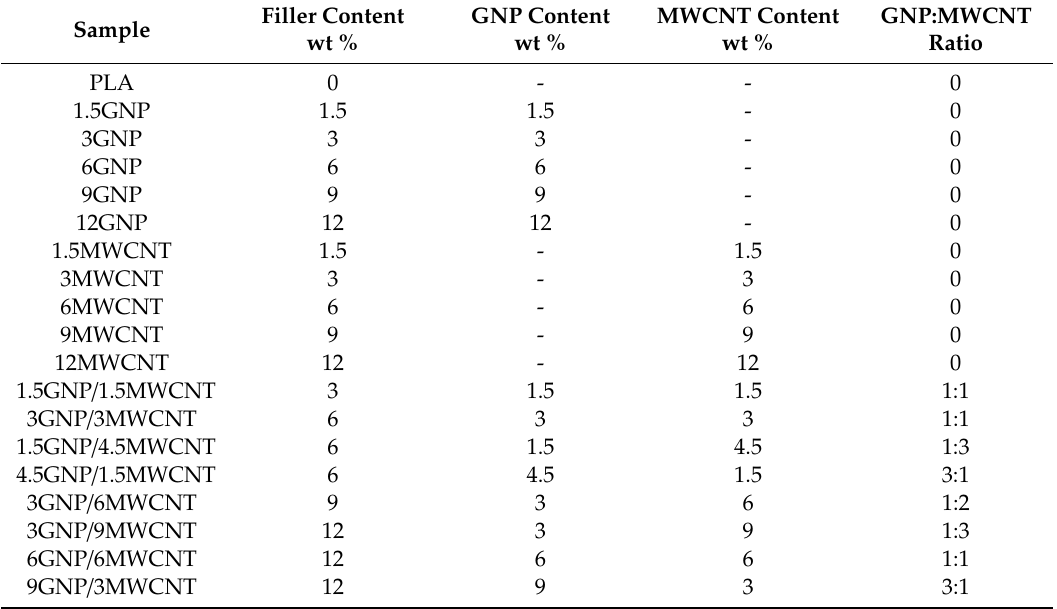
Figure 2. Schematic illustration of production line of the test samples. From left to right: screw extruder for filaments manufacturing to be used with a 3D printer in order to obtain specimens for testing. Table 2. List of mono-filler and bi-filler nanocomposite compounds under investigation in the present study.